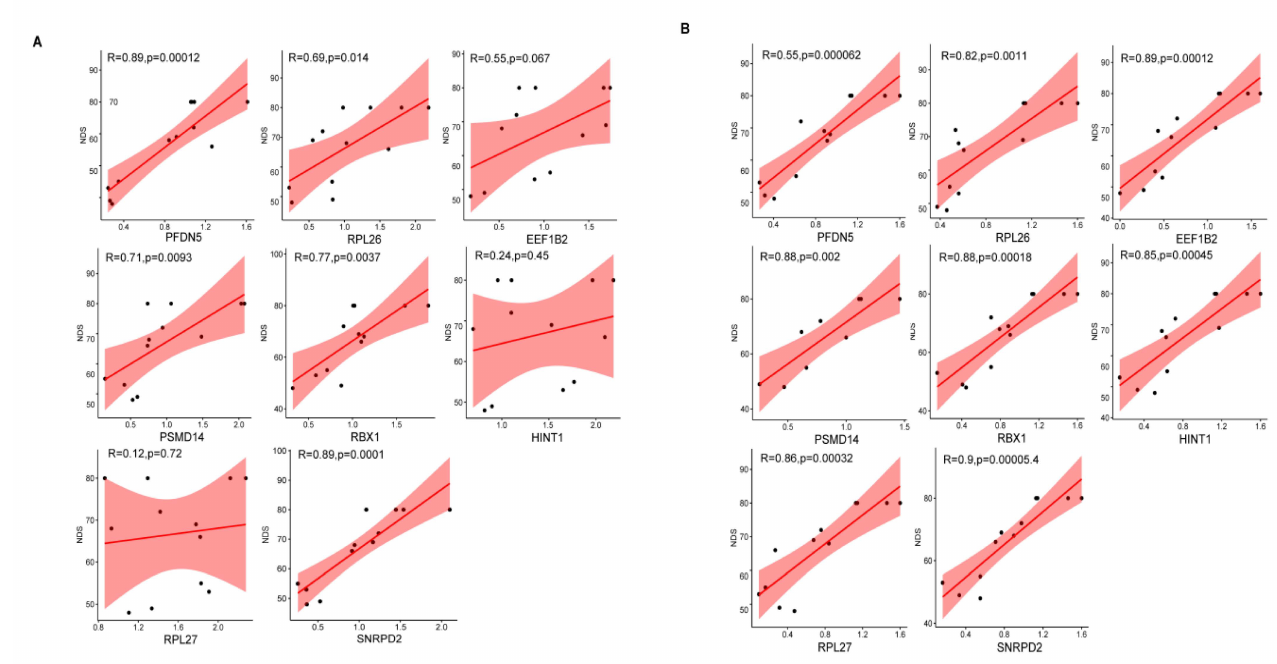
Figure 8. Correlation analysis between gene expression levels and protein expression levels of the 8 hub genes and NDS scores in rats. ( A ) Protein expression levels of the 8 hub genes and NDS scores in rats. ( B ) Gene mRNA expression levels of the 8 hub genes and NDS scores in